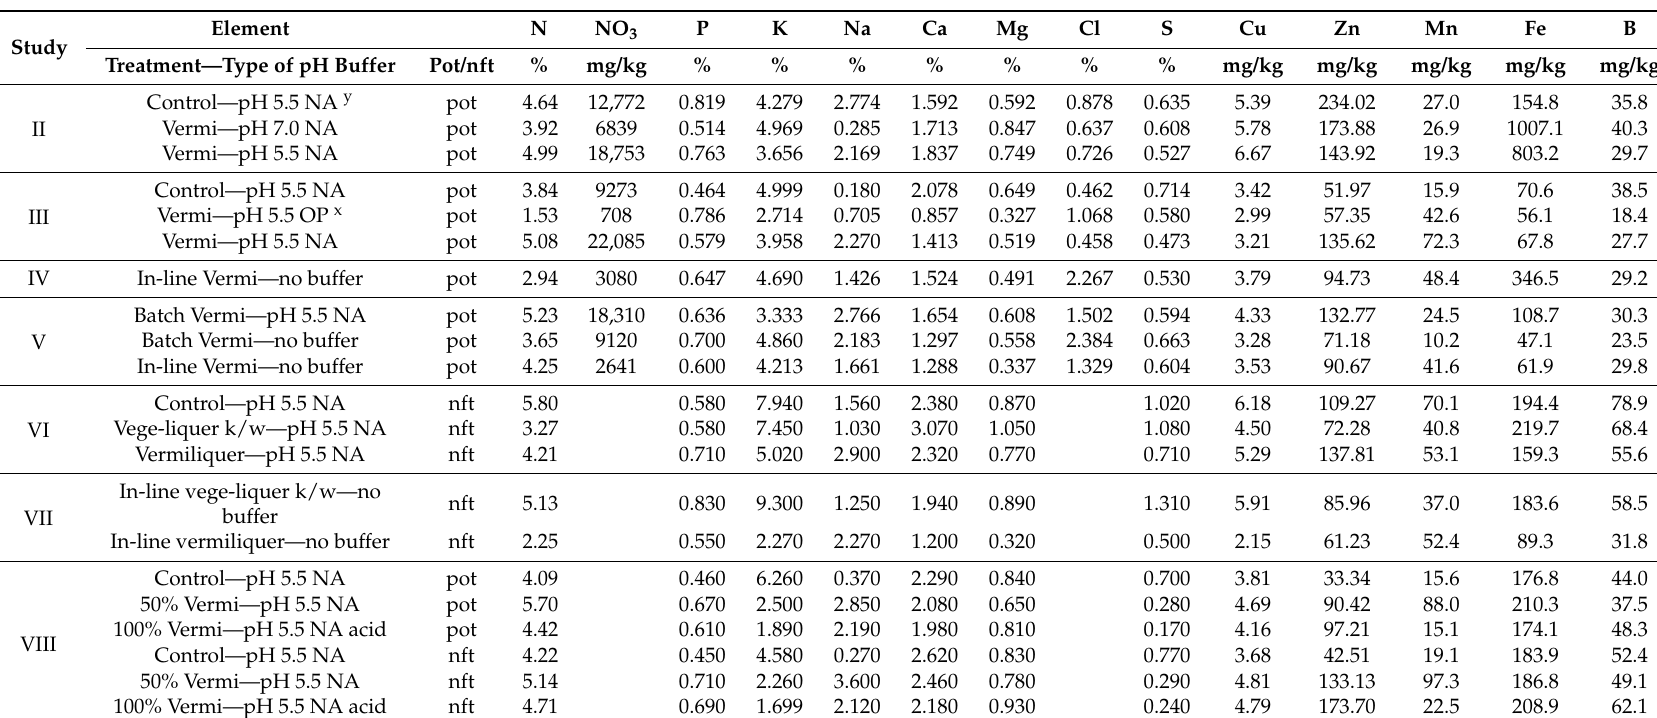
Table 3. Summary of the concentration of some macro and micro-nutrients in shoot tissues in different studies, expressed on a dry weight basis. Batch system unless stated otherwise. Paunch compost unless k/w = kitchen